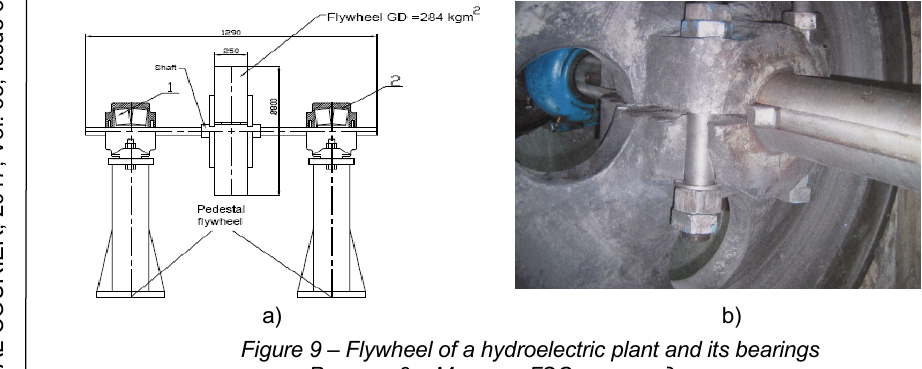
Figure 9 – Flywheel of a hydroelectric plant and its bearings Рисунок 9 – Маховик ГЭС и его подшипник Слика 9 – Замајац хидроелектране и његово